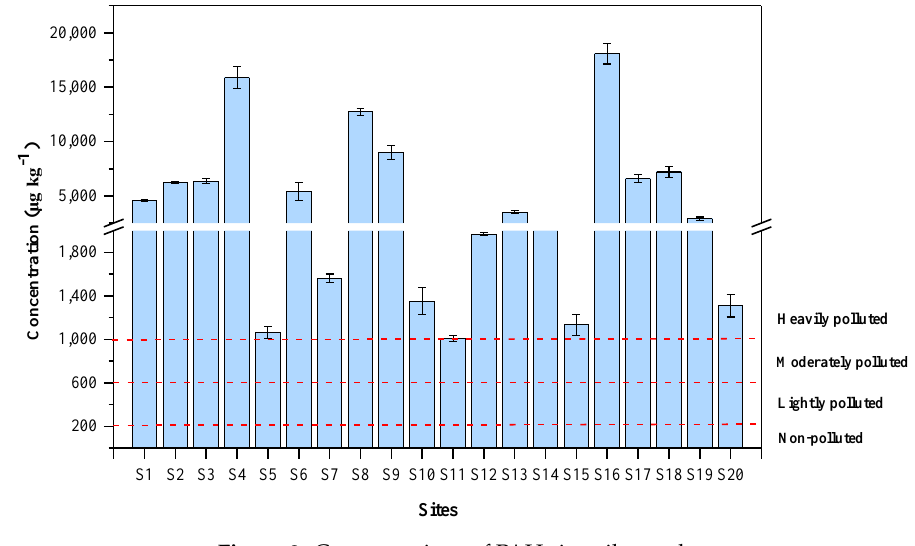
Figure 2. Concentrations of PAHs in soil samples. Int. J. Environ. Res. Public Health 2020 , 17 , x FOR PEER REVIEW